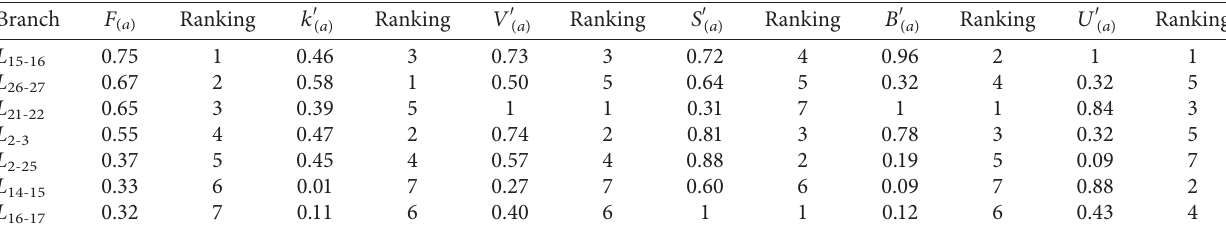
Table 2: Vulnerable branches of IEEE39 node system.